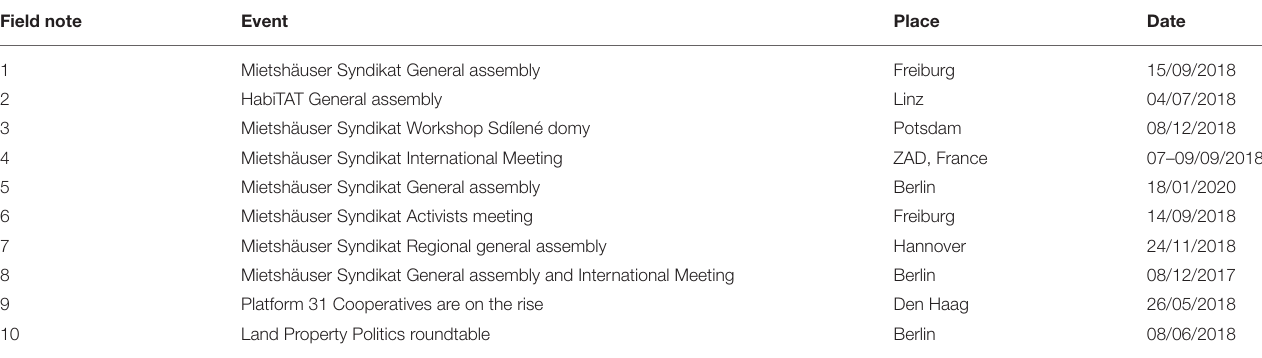
TABLE 2 | Sample of participant observations (2017–2021)